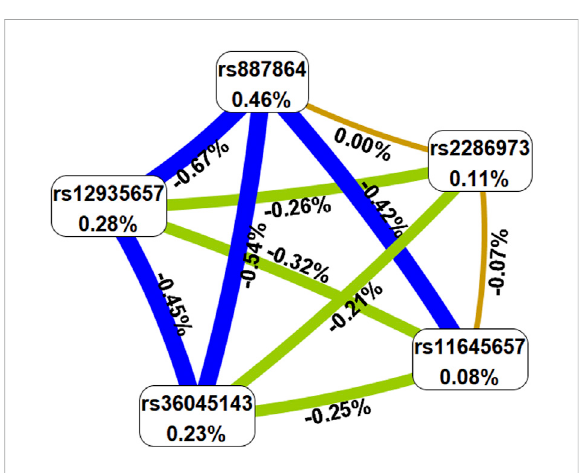
FIGURE 2 The circle graph showed that the interaction between rs2286973 and rs887864 was the strongest, with the information gain (IG) value 0.00%. Antagonism was indicated by blue, green and